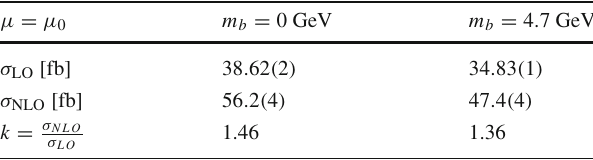
Table 1 Total cross sections at LO and NLO for the central scale and for massless and massive b